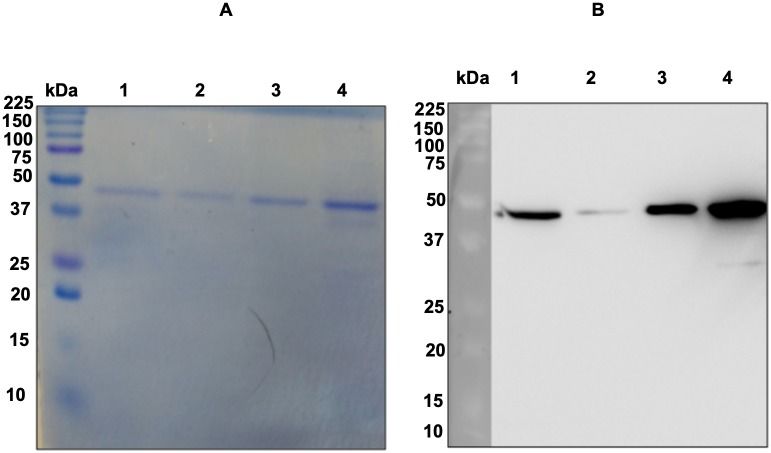
Coomassie blue-stained SDS-PAGE and western blotting anti-his tag with the purified rMEA.Purified rMEA was run in 12% gel (A). Replicate gel was transferred to PVDF membrane and probed with mouse anti-histidine tag followed of anti-IgG conjugated with peroxidase (B).